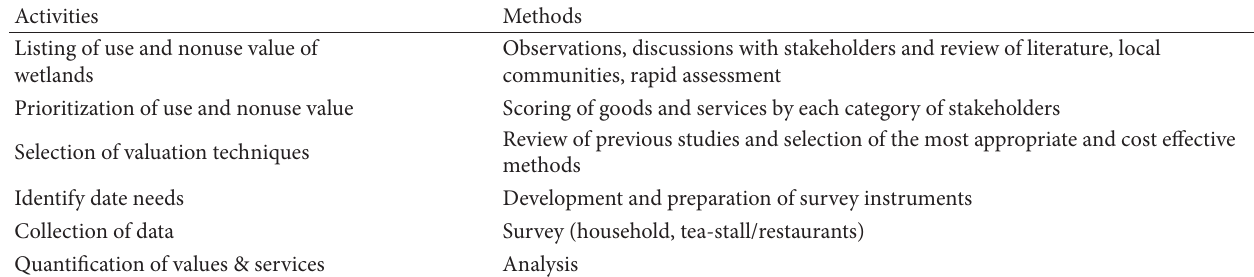
Table 1: Sequential steps followed for total economic valuation.